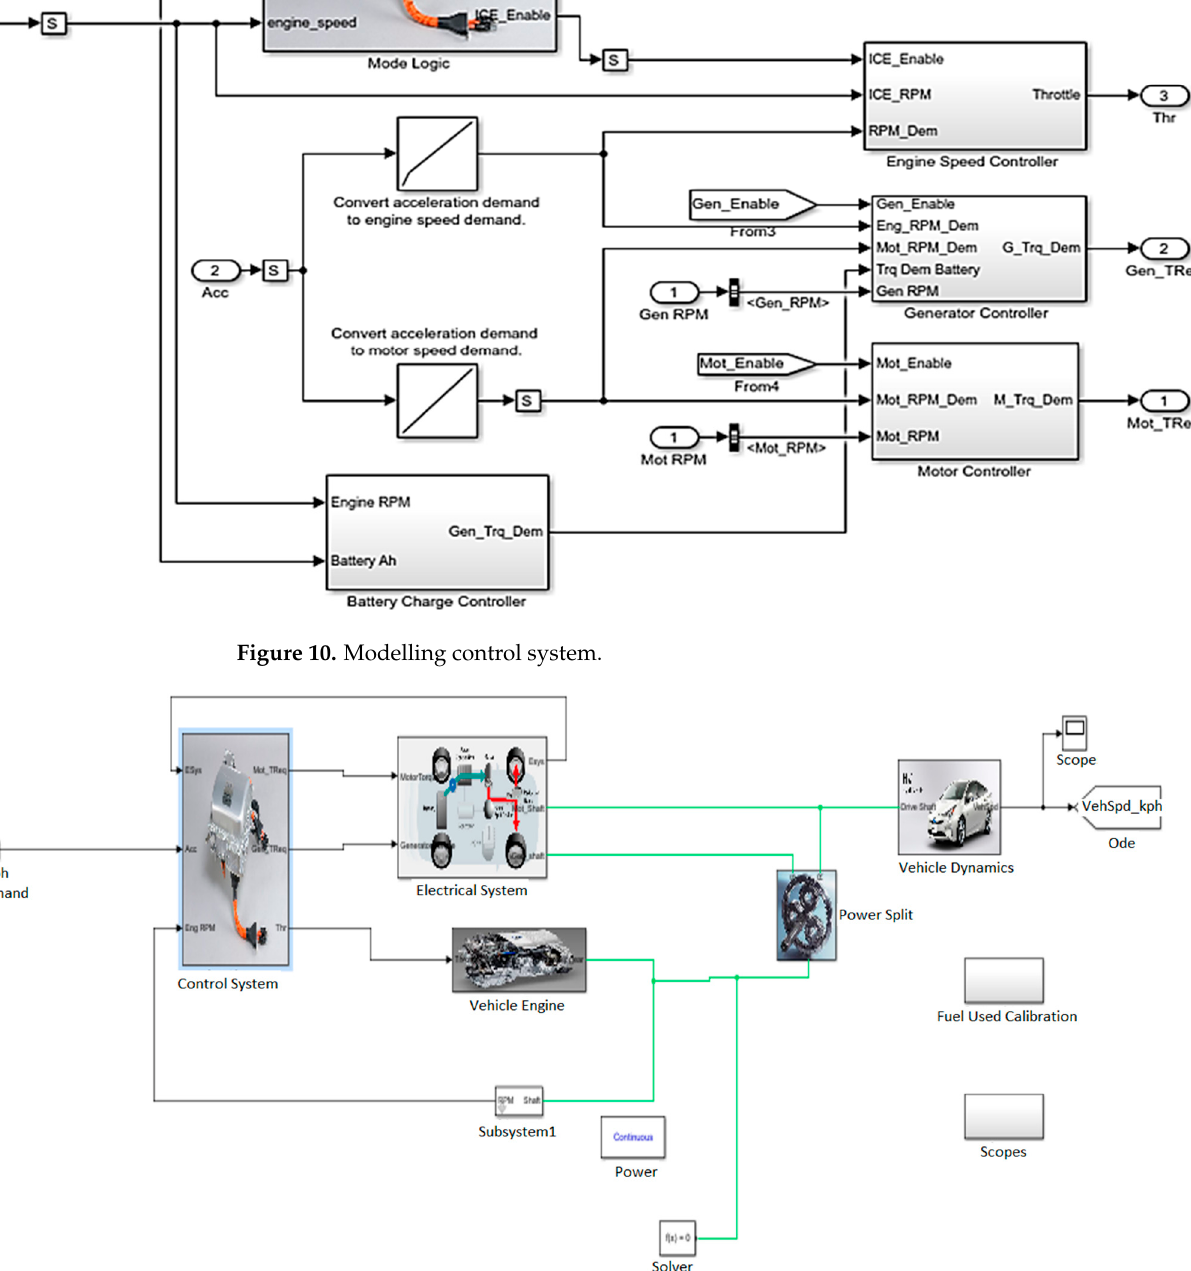
Figure 11. Simulink model for the HEV .